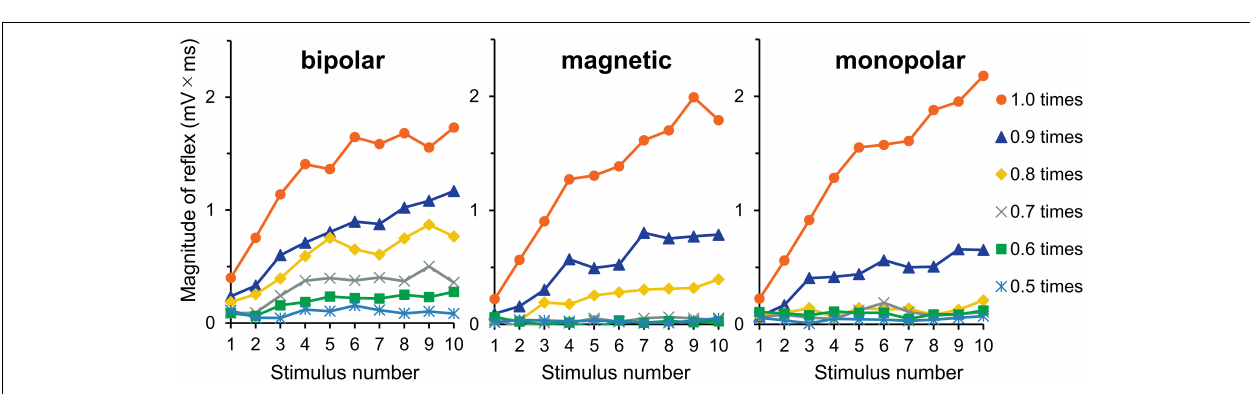
FIGURE 4 | Experiment 2. Mean reflex magnitude for 10 consecutive stimulations at six different stimulation frequencies. Although the wind-up effect is present for all frequency conditions, it is more obvious at higher frequencies.